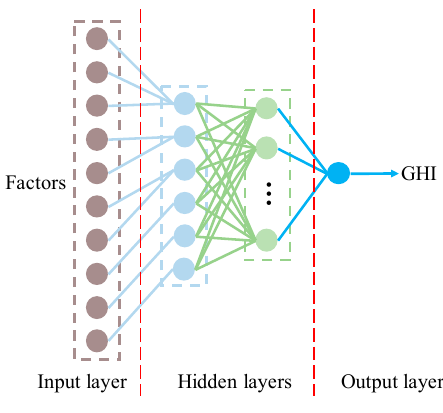
Figure 2. The structure of Sub-Model 3 (SEM-MLP) based on multilayer perceptron (MLP) and